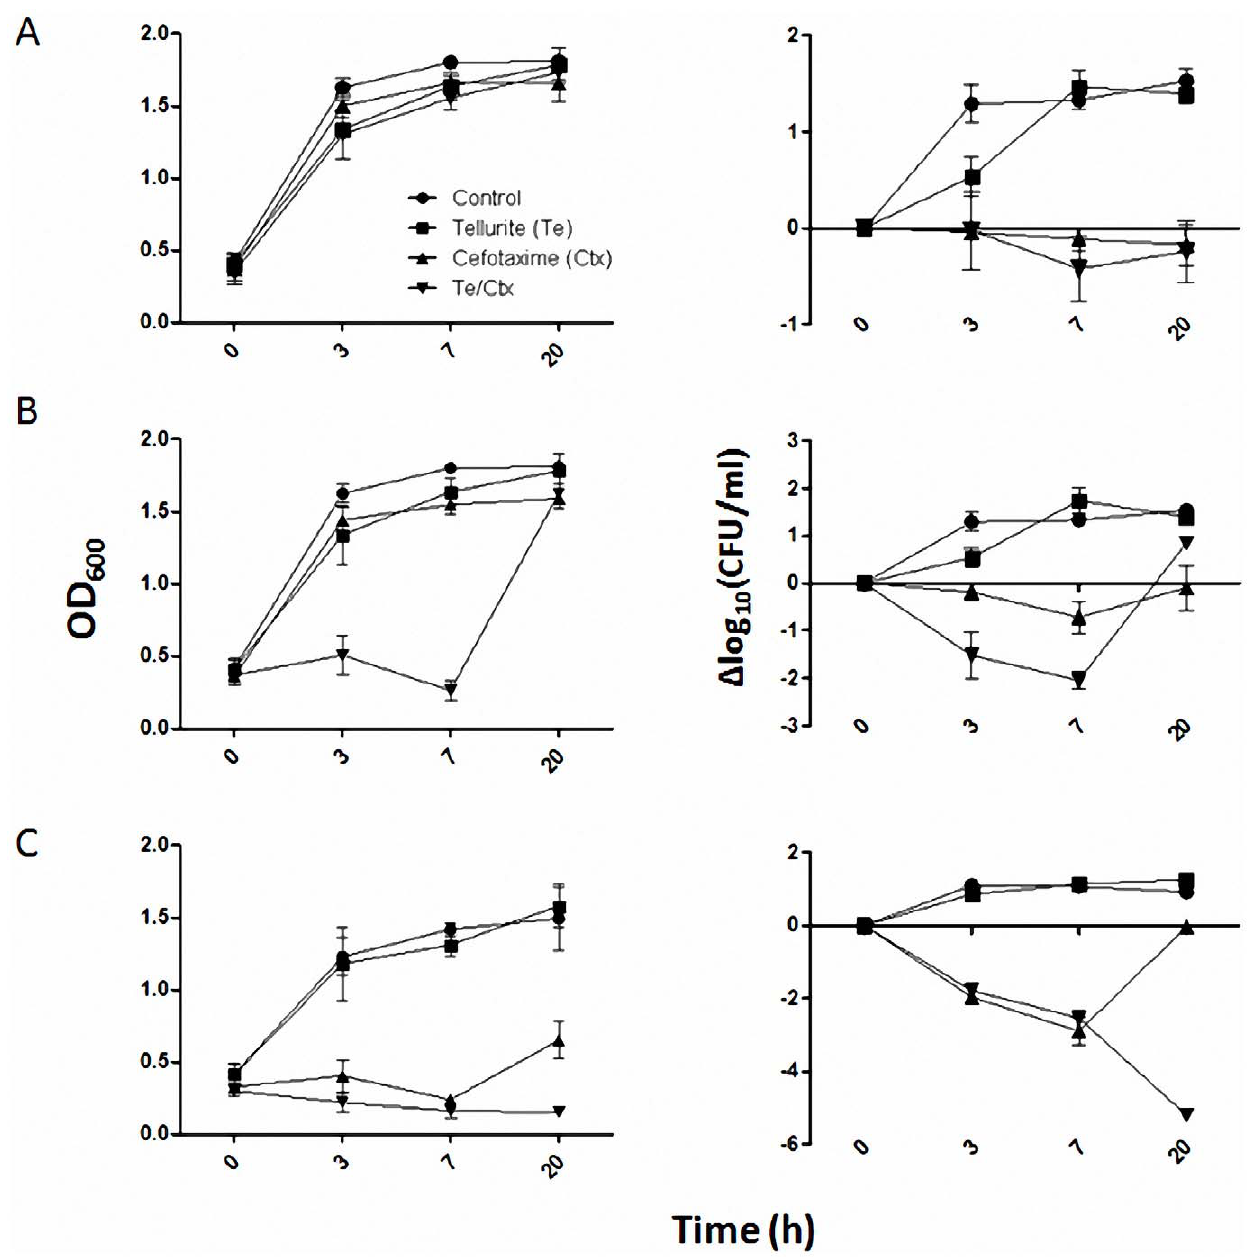
Figure 3. Cefotaxime and potassium tellurite acts synergistically in E.coli . Growth curves (left panels) and cell viability (right panels) were determined at the indicated time intervals for E. coli exposed to 0.065 (A, sublethal), 0.13 (B, MIC) and 0.5 m g/ml (C, lethal) CTX in the absence or presence of 200 nM tellurite. Controls contained no tellurite or cefotaxime. Data represent the mean of at least 3 independent trials. Refer to inset in panel A for symbol meaning.